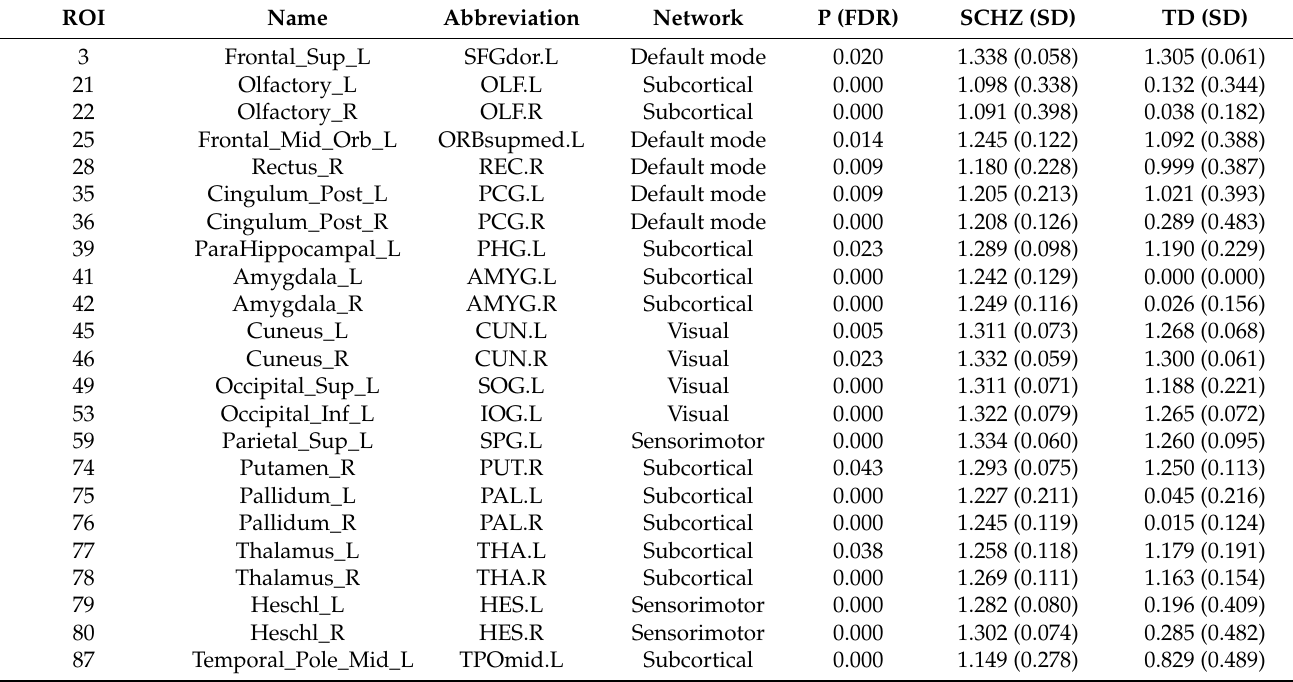
Table 2. Brain regions showing significant differences in the entropy of the multiplex degree.